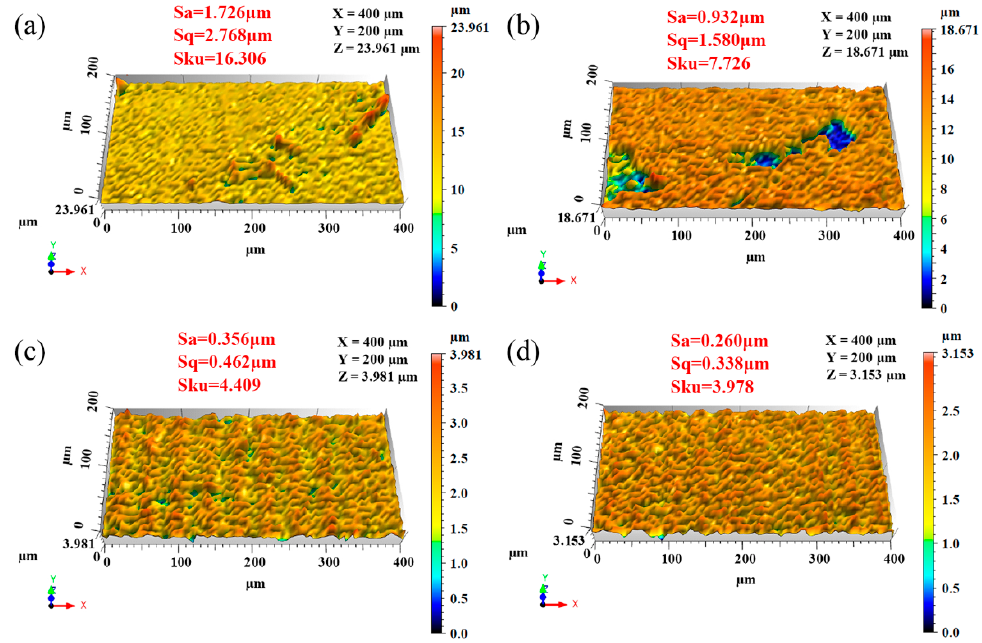
Figure 7. Typical wear scar roughness of the Blank / 10 specimen ( a ), CRR / 10 specimen ( b ), Blank / 20 specimen ( c ), and CRR / 20 specimen ( d ).